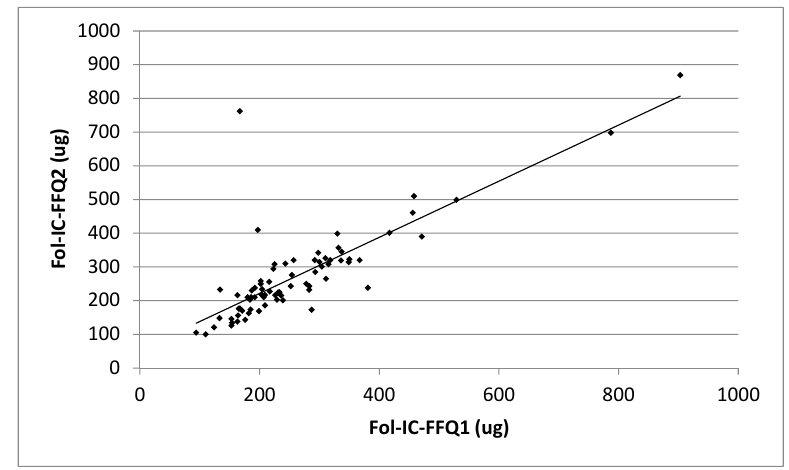
Figure 4. Analysis of the correlation between the Fol ‐ IC ‐ FFQ1 and Fol ‐ IC ‐ FFQ2 daily folate intake (Spearman rank correlation coefficient; p = 0.0000, R = 0.7995). Fol ‐ IC ‐ FFQ1: food frequency